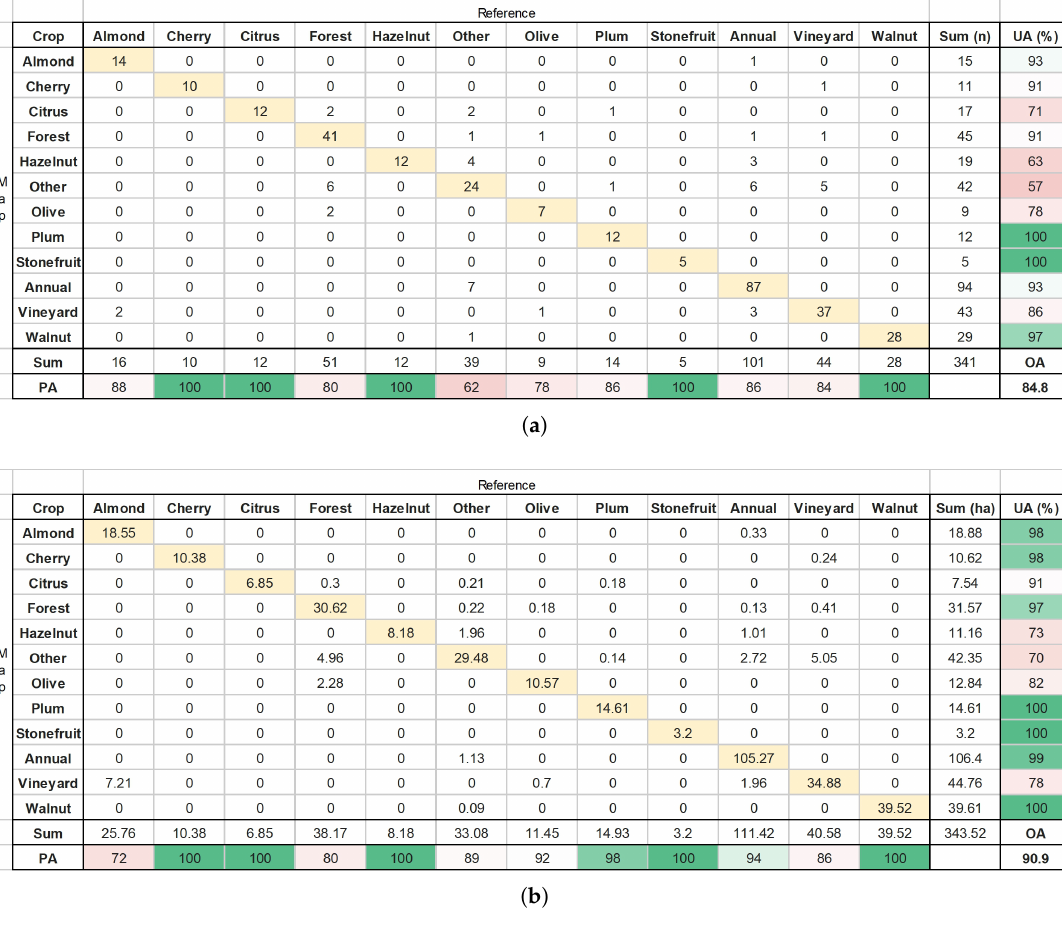
Figure 17. Confusion matrices for the final map accuracy. ( a ) Count-based. ( b )